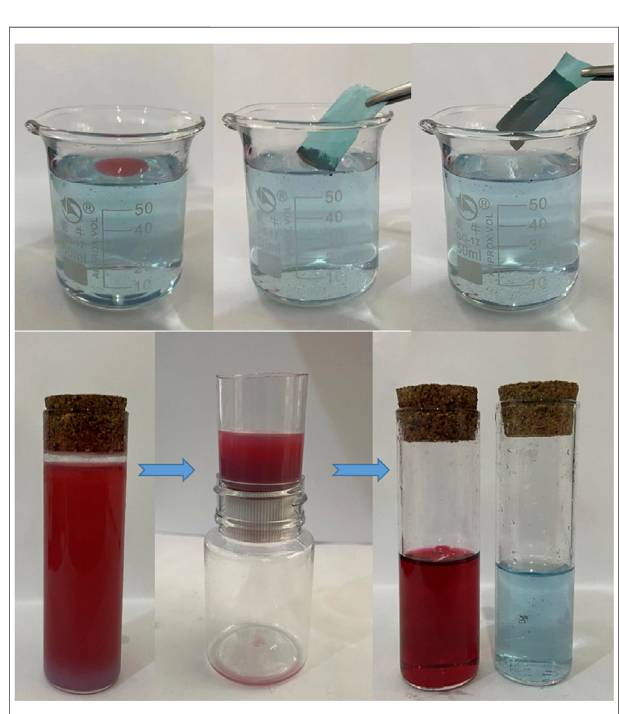
FIGURE 9 | The process of oil fl oating adsorption and oil-water separation.